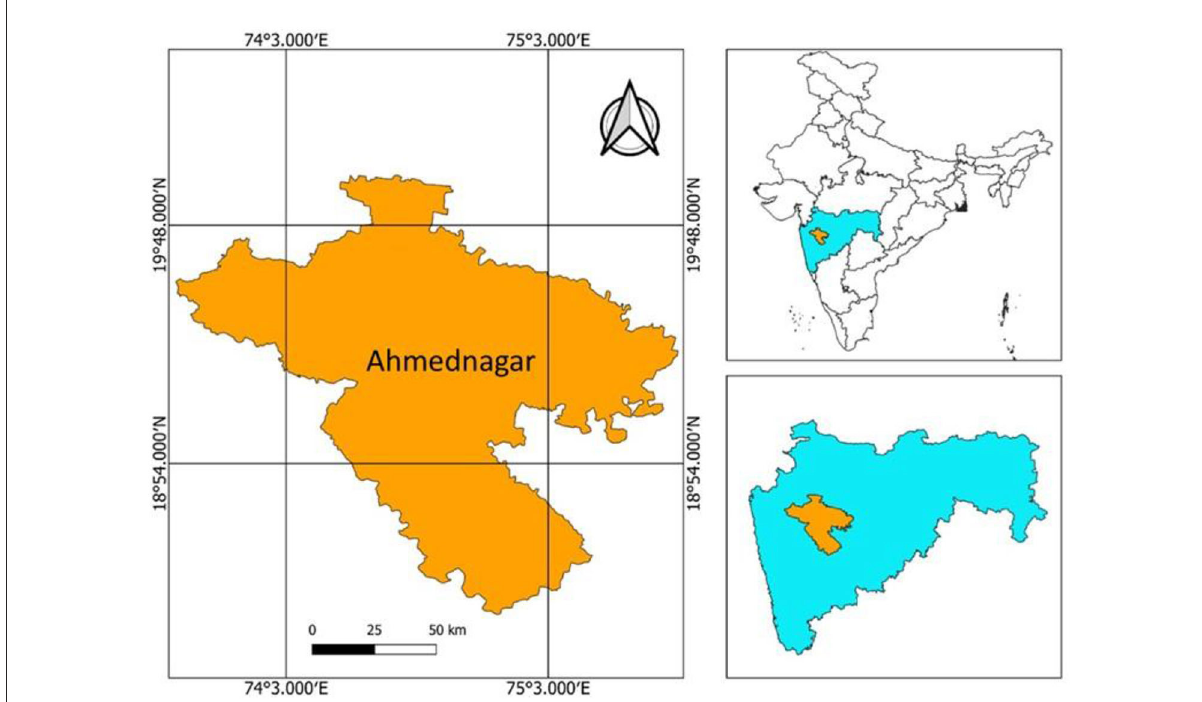
FIGURE1 Study area geographical location of Ahmednagar district (Orange) in Maharashtra state (blue) of